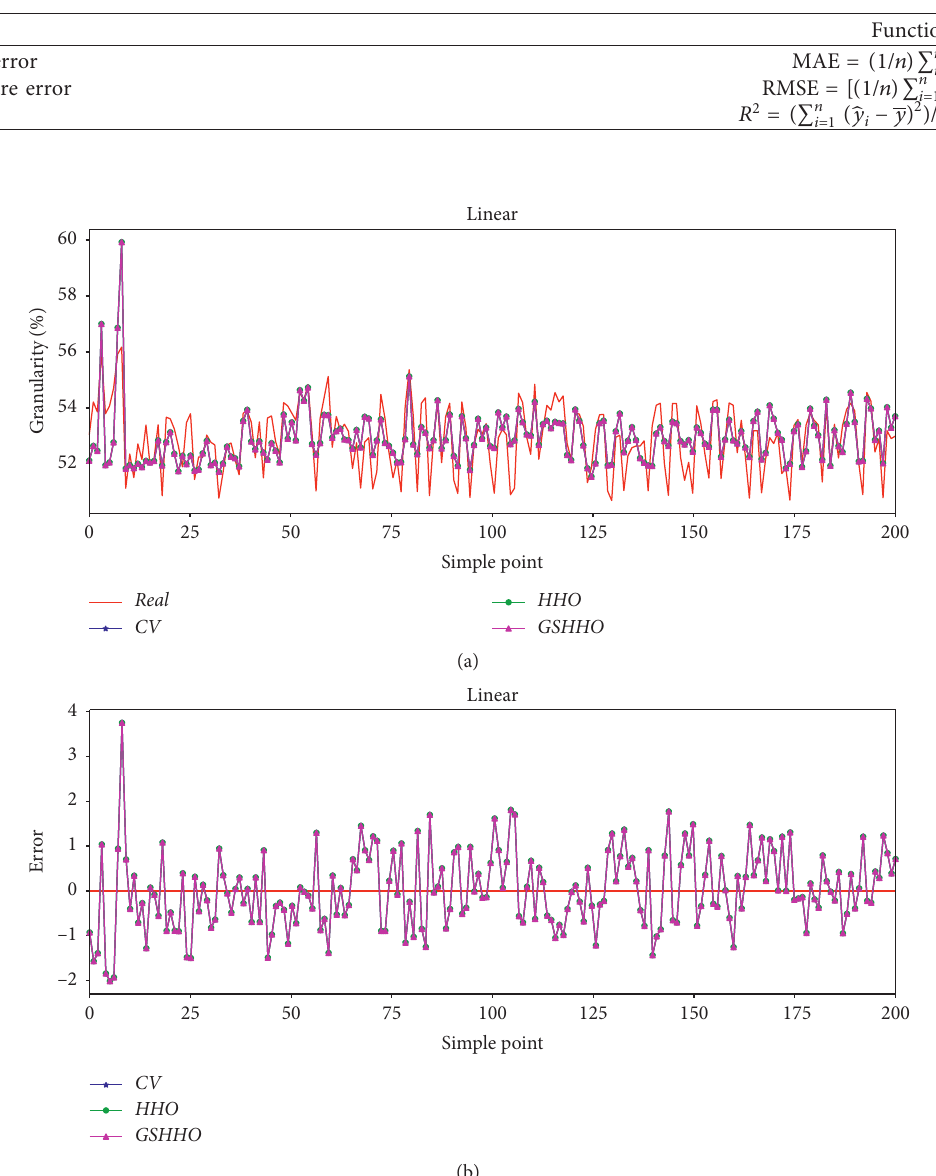
Table 5: Quantitative indicators of soft-sensor